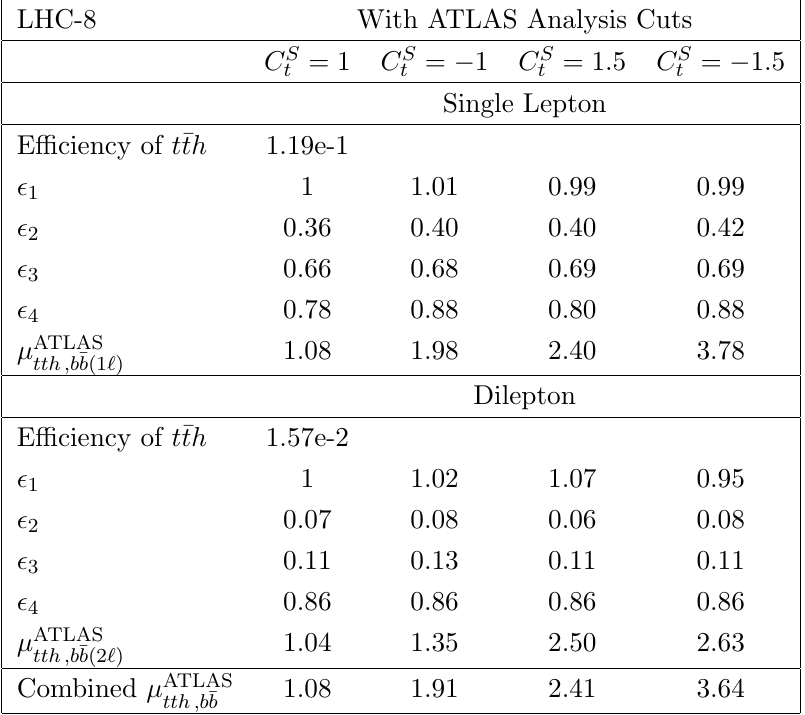
Table 10 . Category b (cid:22) b : the same as table 9 but with the ATLAS